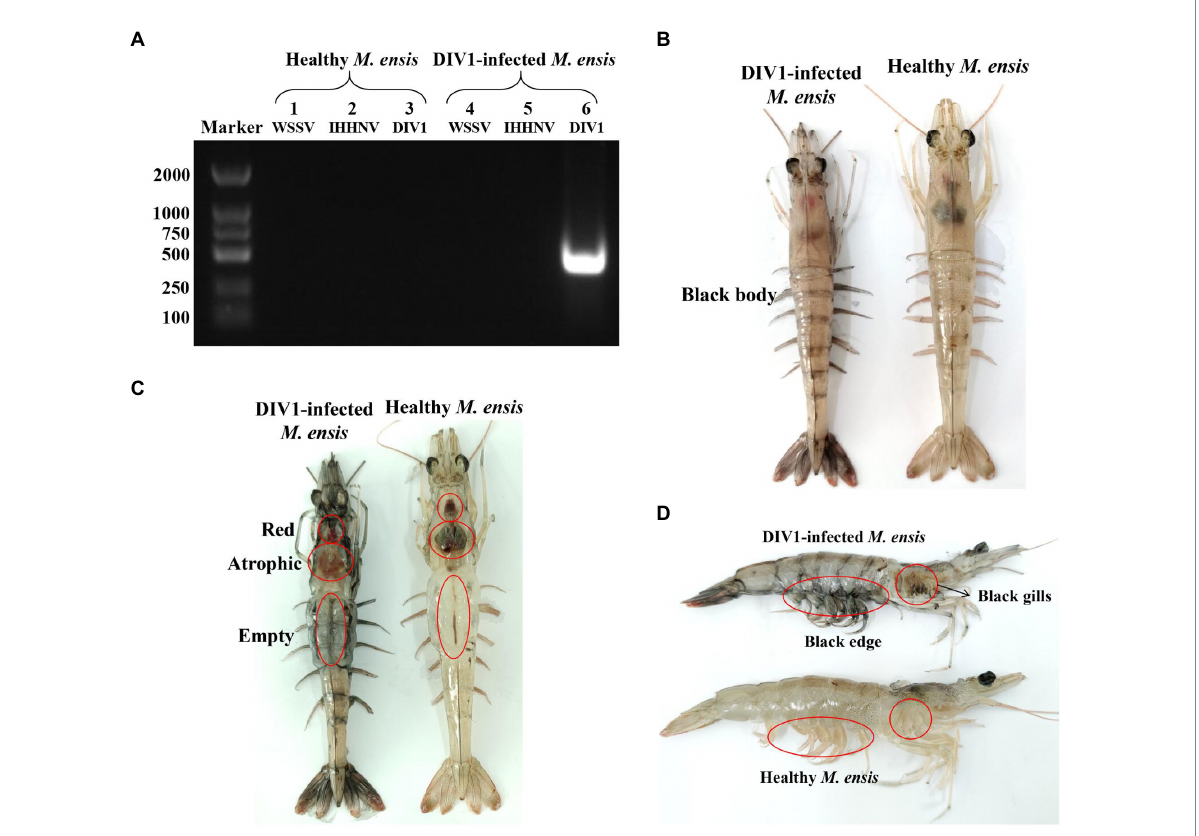
FIGURE 2 Clinical symptoms and virus detection of M. ensis. (A) Virus detection of healthy and infected M. ensis used for LC 50 test. Marker: DL2000 molecular mass marker; Lane 1–3: PCR amplified products used for WSSV, IHHNV, and DIV1 detection in healthy M . ensis ; lane 4–6: PCR amplified products used for WSSV, IHHNV, and DIV1 detection in DIV1-infected M . ensis . (B–D) Clinical symptoms of DIV1-infected M.